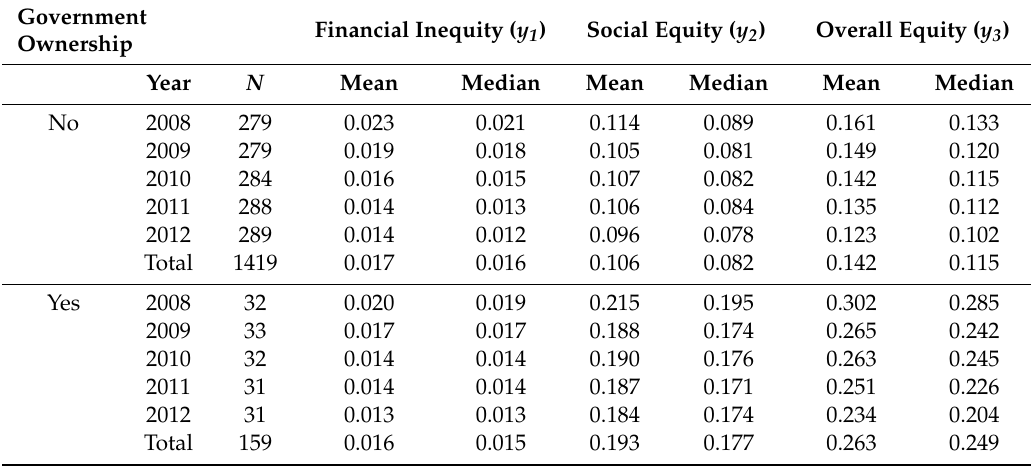
Table 5. Distribution of equity indicators (2008–2012) by